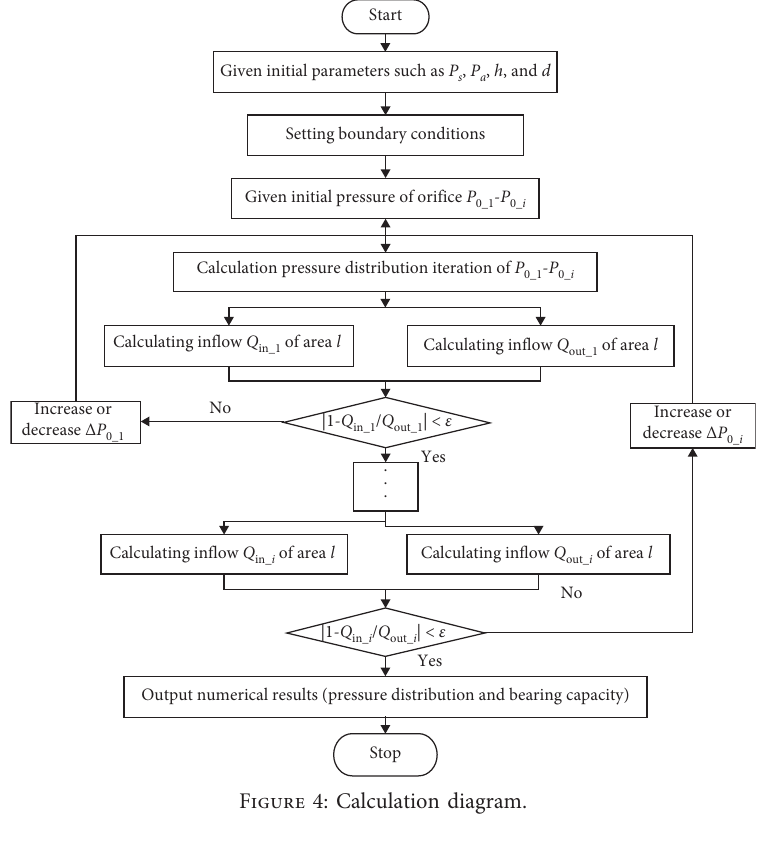
Figure 4: Calculation